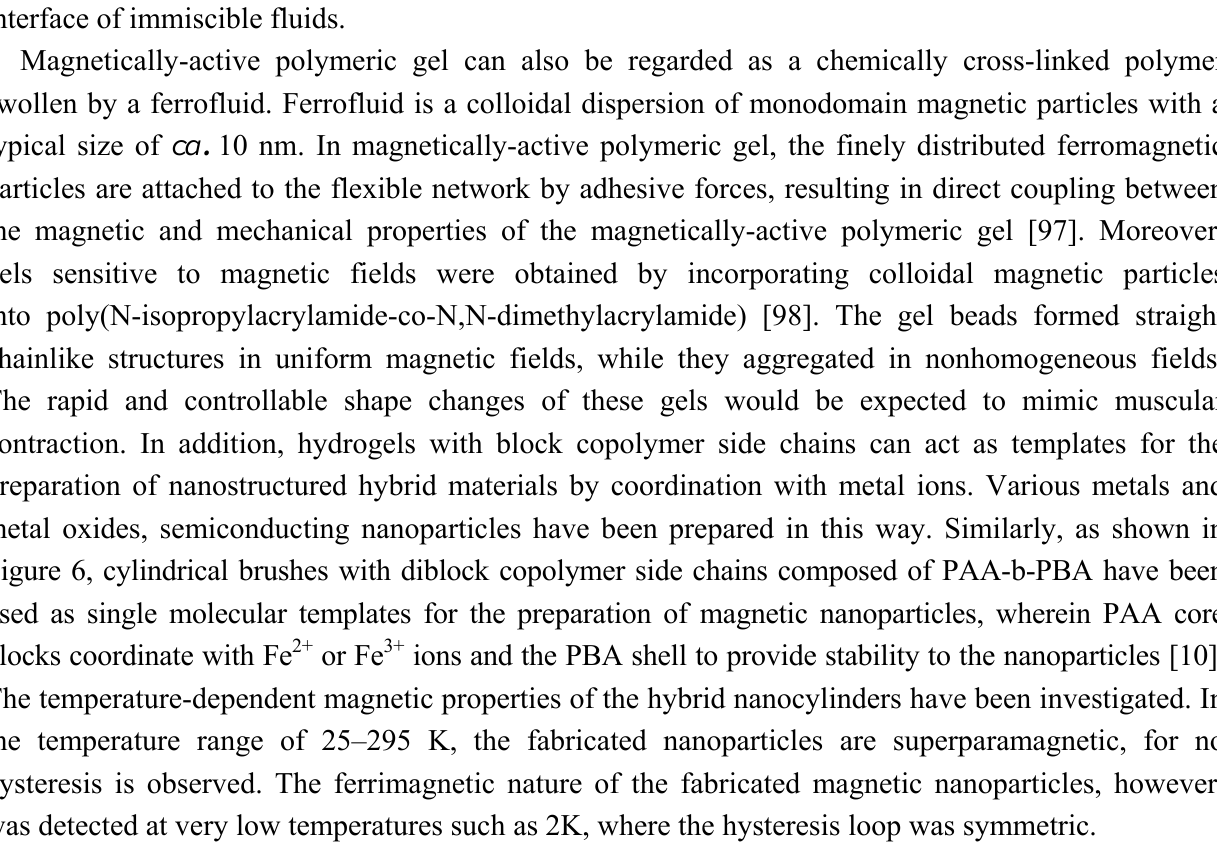
Figure 6. Schematic illustration for the synthesis of a wire-like assembly of magnetic nanoparticles inside a cylindrical polymer brush. ( a ) polymer brush with PAA core and PnBA shell; ( b ) neutralized polymer brush with poly(sodium acrylate) core (Na + ions are not shown); ( c ) polychelate of the brush with Fe 2+ or Fe 3+ ions; and ( d ) hybrid nanocylinder of the brush and magnetic nanoparticles. Reprinted (adapted) with permission from